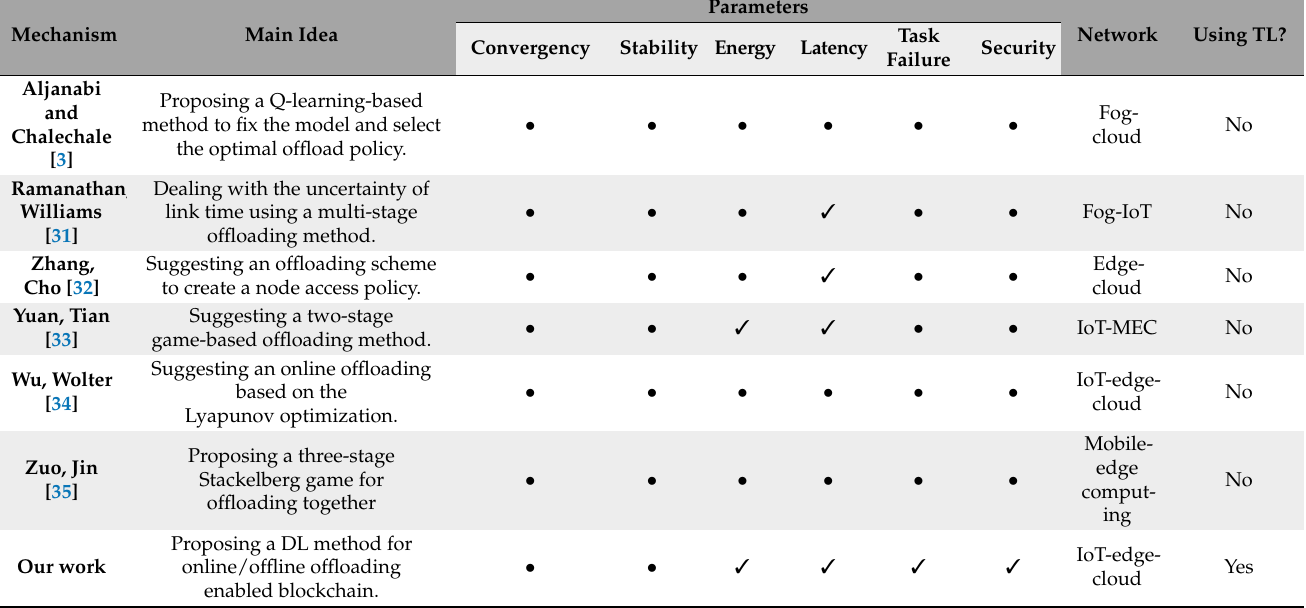
Table 1. A comparison of the discussed IoT offloading methods and their